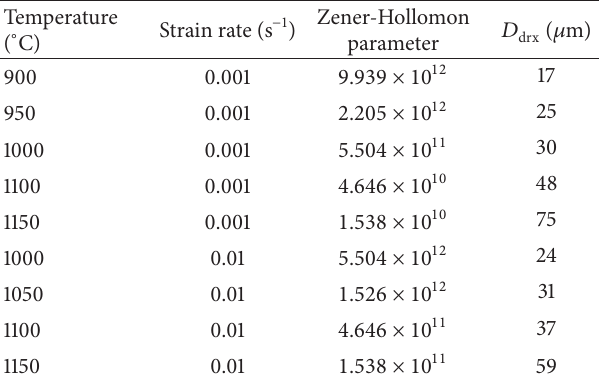
under different deformation